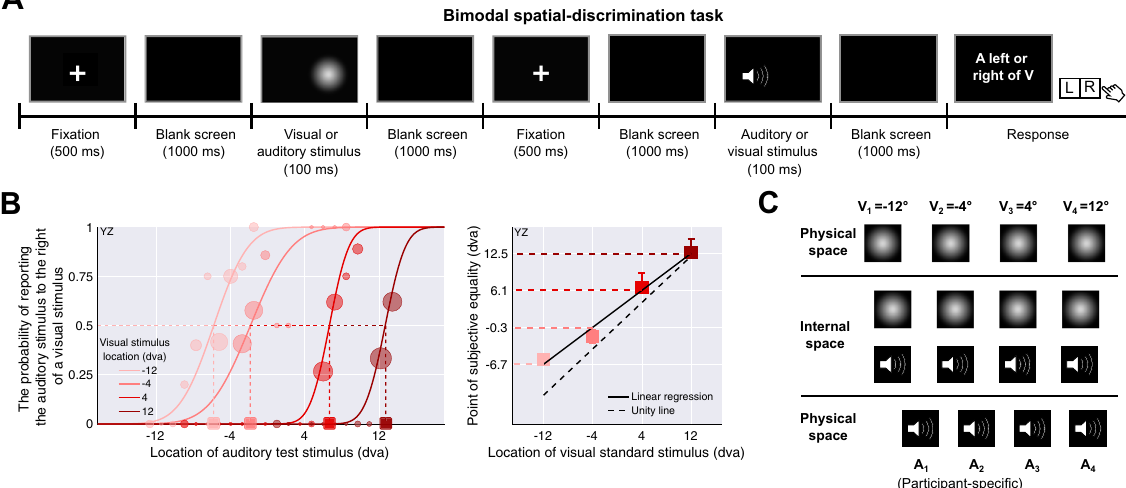
Figure 2. Experimental procedure and behavioral results: bimodal spatial-discrimination task, preparatory experiment 1. ( A ) Task timing. Participants were presented with a visual standard and an auditory test stimulus in random order. After stimulus presentation, they reported whether they had perceived the auditory stimulus to the left or right of the visual stimulus. Feedback was not provided. ( B ) Behavioral results of representative ◦ participant YZ. Left panel: binned data (dots; bin size ≈ 1 ; marker area proportional to the number of trials in each bin), and best-fitting psychometric functions (curves) for four visual standard stimulus locations (shades of red). Squares: points of subjective equality (PSE). Right panel: PSE as a function of visual stimulus location. Error bars: 95% bootstrapped confidence intervals (some are smaller than the marker size). Black dashed line: identity line; black solid line: linear regression line fitted to the PSEs; red dashed lines: the locations of the four auditory stimuli perceived as aligned with the four visual standard locations according to the regression line. ( C ) Stimulus locations in physical and perceptual space. Top panel: four visual stimulus locations in physical space used in all experiments; middle panel: the four pairs of a visual and an auditory stimulus that were aligned in internal perceptual space; bottom panel: the four participant-specific auditory stimulus locations in physical